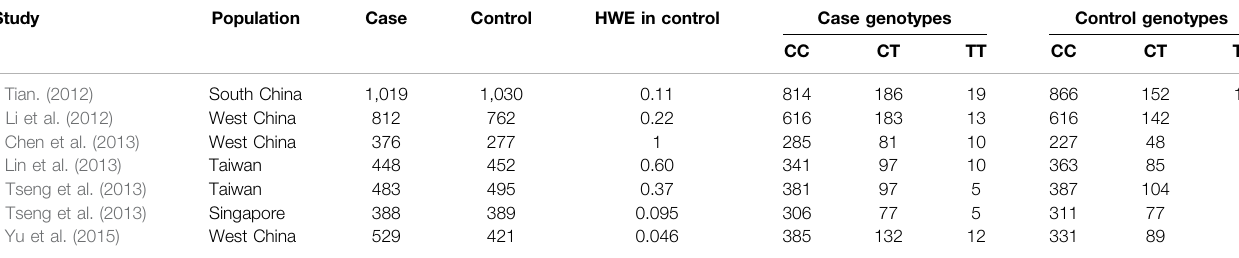
TABLE 1 | Characteristics of seven eligible studies on the association between rs1564282 and PD. Study Population Case Control HWE in control Case